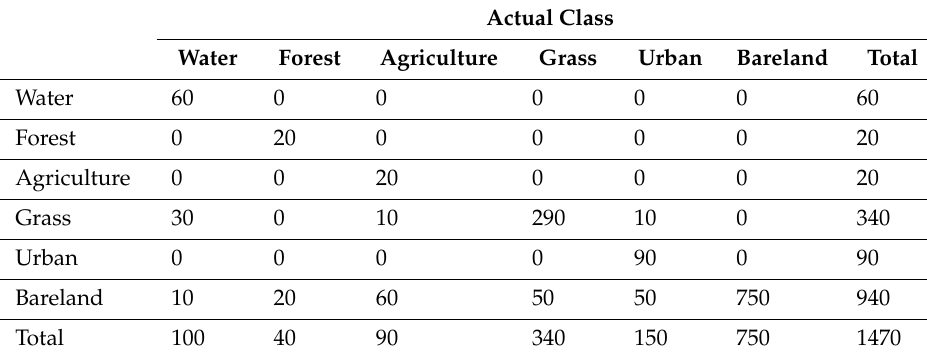
Table 7. Confusion matrix